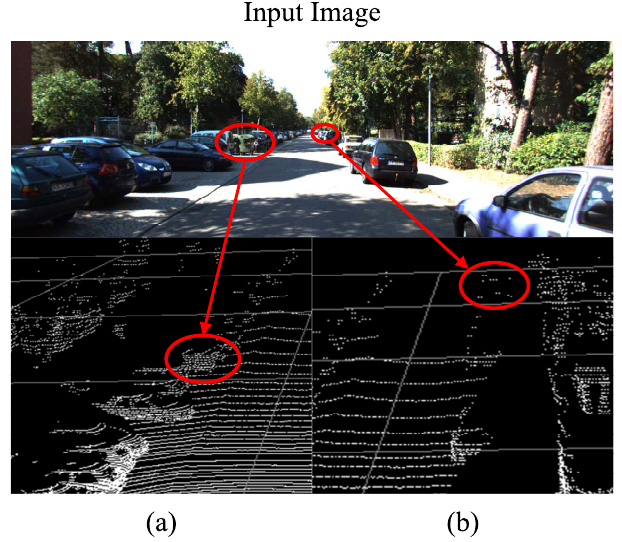
Figure 1. ( a ) The background obstacle has a similar 3D structure to a car. It is difficult to distinguish them in the point cloud. ( b ) The points of the distant car are too sparse to determine the bounding